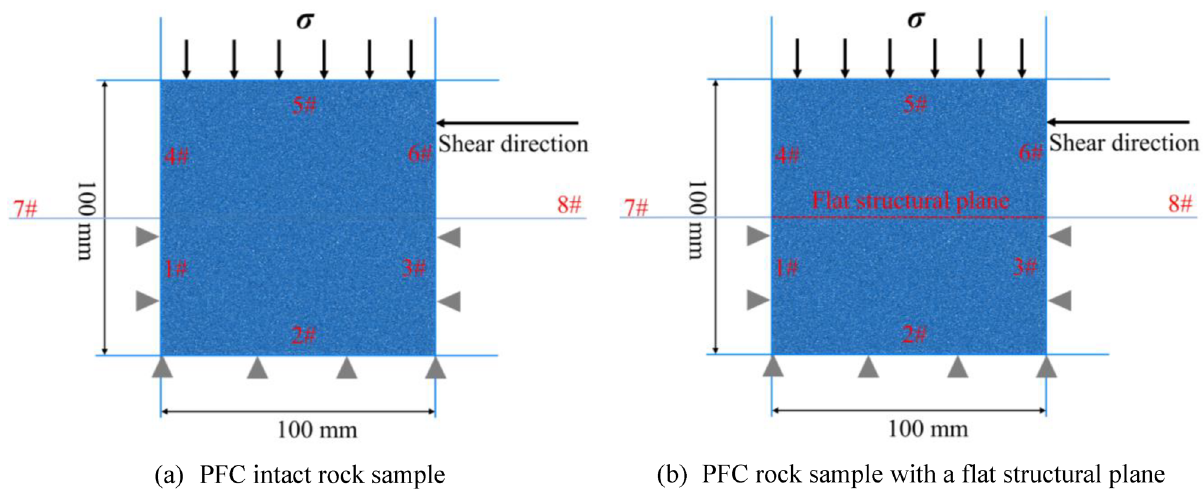
Figure 2. PFC intact rock sample and the PFC rock sample with a flat structural